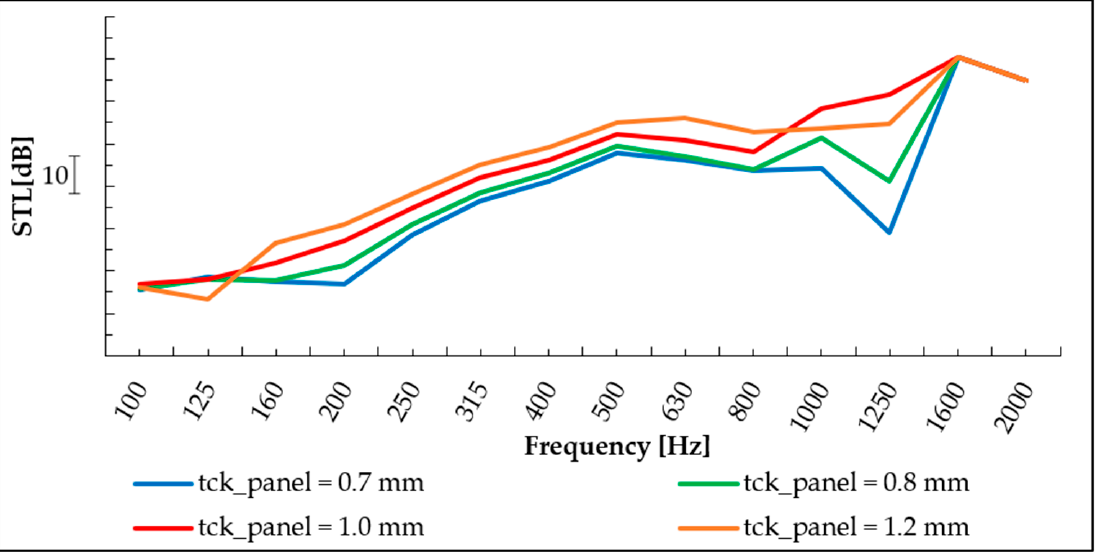
Figure 7. STL numerical results keeping the nominal dimensions for a cell and h cell and varying tck panel .